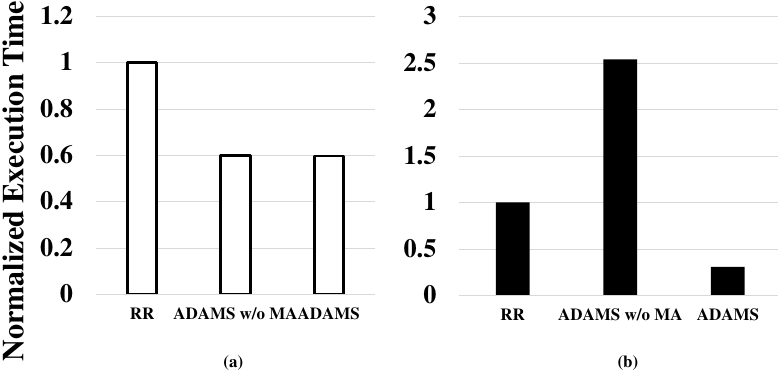
Figure 10. Case study of ADAMS for the IRIS application with ( a ) small set and ( b ) large